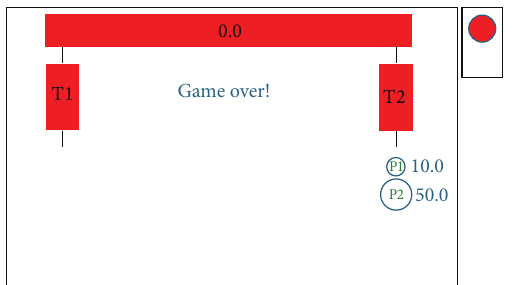
Figure 5: Rational Pigs outcome ( Press-Don’t press choices).